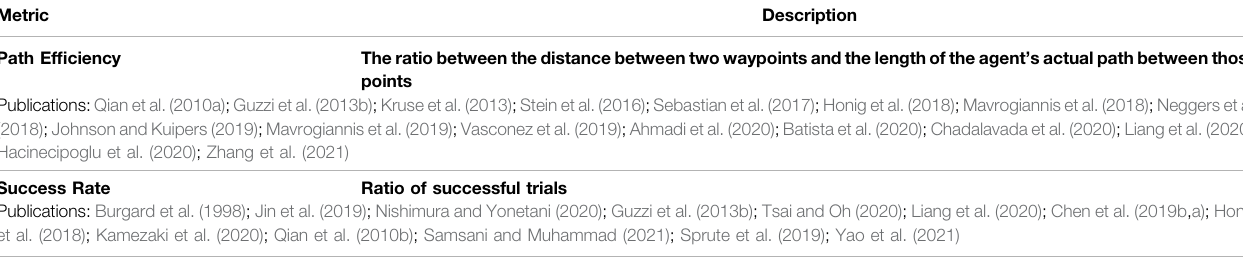
TABLE 4 | Evaluation metrics for navigation